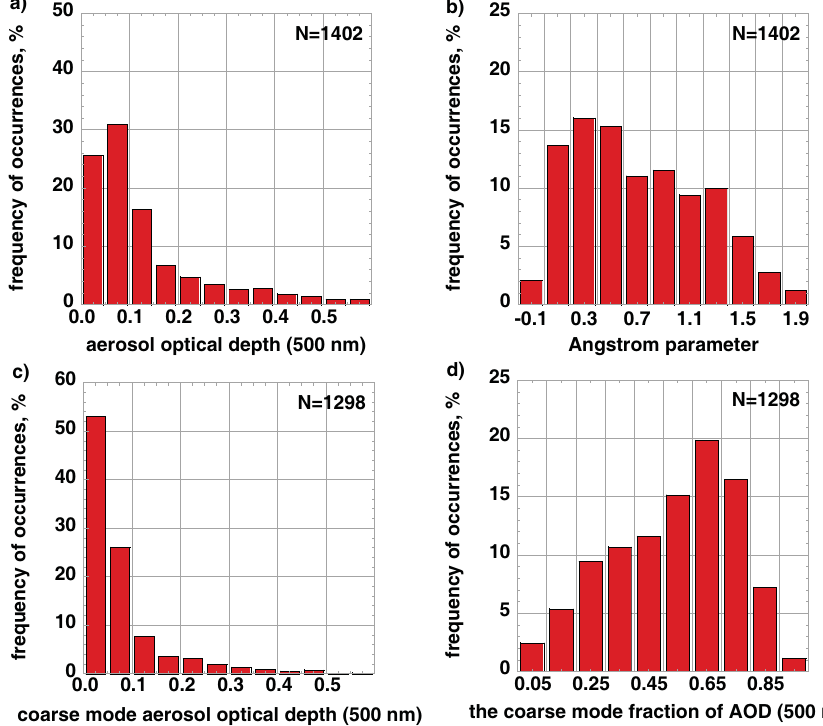
Fig. 7. Frequency of occurrences of daily averaged AOD (a) , Angstrom parameter (b) , coarse mode AOD (c) , coarse mode fraction of AOD (d) for oceanic areas excluding the inland